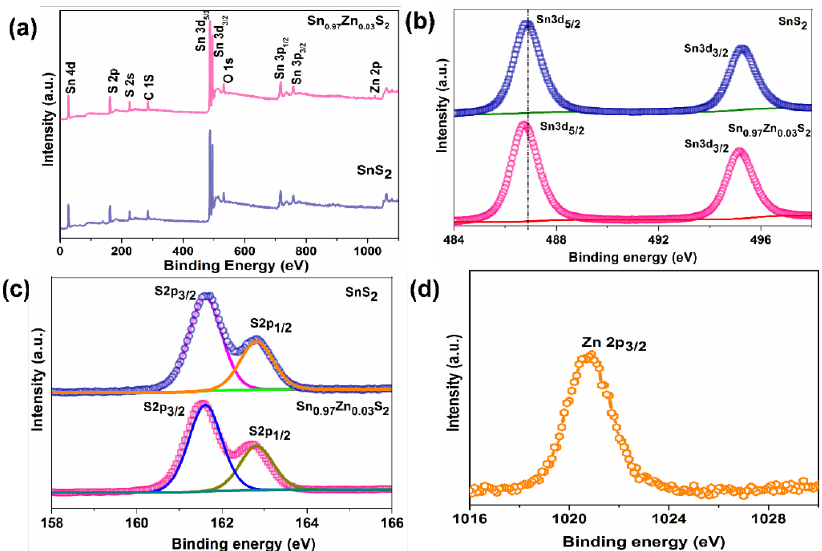
Figure 5. ( a ) Full survey spectra of SnS 2 and Sn 0.97 Zn 0.03 S 2 sample. ( b ) X-ray photoelectron spectroscopy (XPS) core level Sn 3d spectra of SnS 2 and Sn 0.97 Zn 0.03 S 2 nanoflakes. ( c ) S 2p core level spectra of SnS 2 and Sn 0.97 Zn 0.03 S 2 nanoflakes. ( d ) Zn 2p core level spectra of Sn 0.97 Zn 0.03 S 2 .